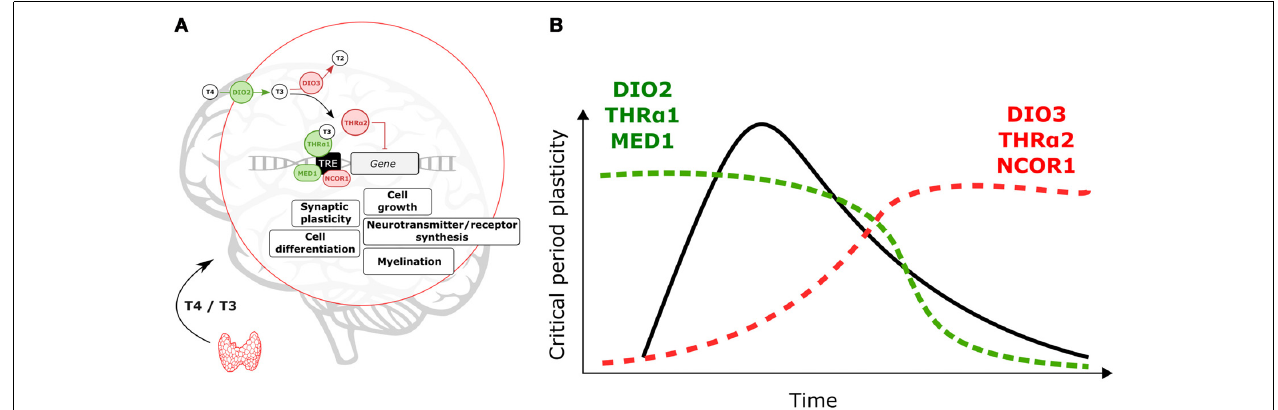
FIGURE 1 | Molecular events controlling locally thyroid hormone (TH)-signaling. (A) Deiodinases, THr α -variants and transcription co-regulators can enhance (green)/repress (red) T3-dependent transcription. (B) Expression levels of DIO2, THR α 1 and MED1 are predicted to increase to support critical period (CP) onset and plasticity. After the CP breaks of TH-action (DIO3, THR α 2 and nuclear receptor coregulator 1, NCOR1) could contribute to decreasing TH-signaling and T3-related changes in gene